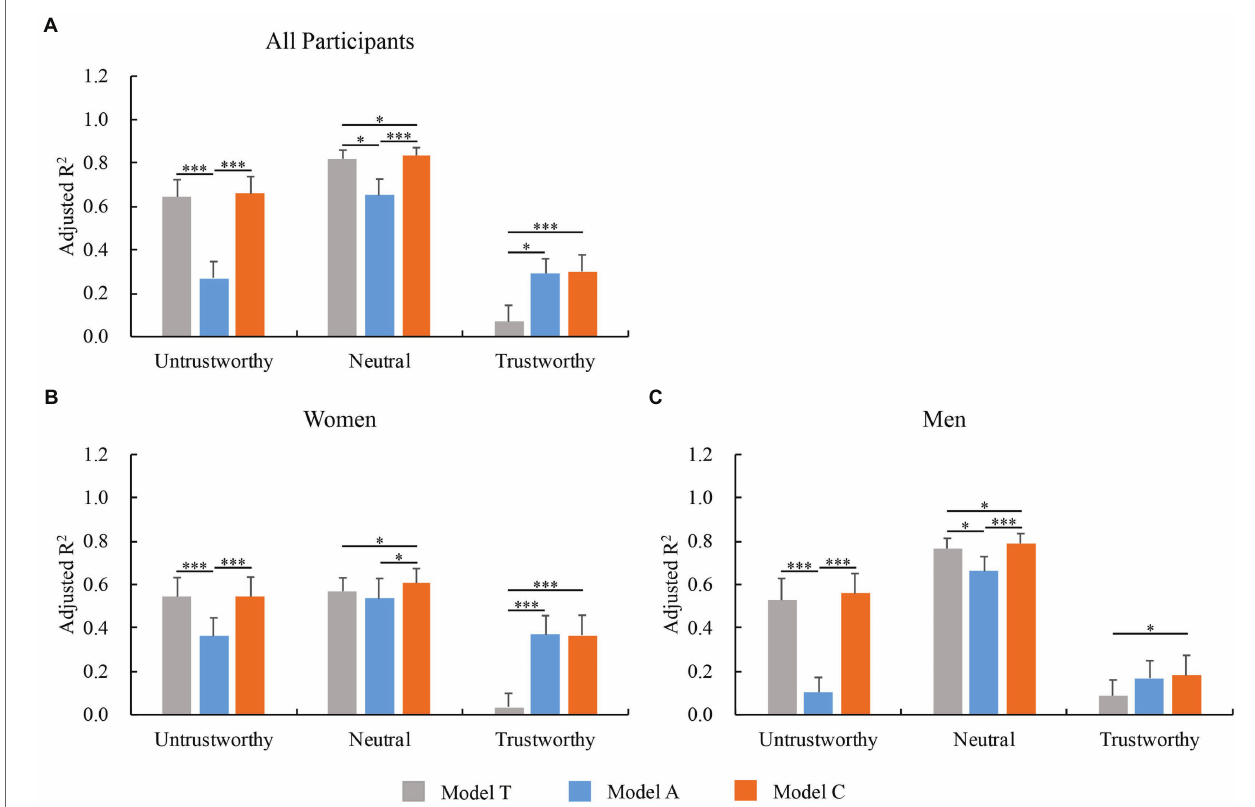
FIGURE 8 | Performance of three regression models [typicality (Model T), attractiveness (Model A), and typicality and attractiveness combined (Model C)] for trustworthiness judgments across (A) all participants, (B) women only, and (C) men only based on faces with different trustworthiness ratings. All tested faces were divided into three sub-groups based on mean ratings of face trustworthiness: Group Untrustworthy, rating < 3; Group Neutral, 3 ≤ rating < 5; Group Trustworthy, rating ≥ 5. To exclude potential effects of different numbers of faces across sub-groups on regression analyses, we randomly chose the same number of faces ( n = 61) from three sub-groups. ∗ p < 0.05; ∗∗∗ p < 0.001. Error bars represent standard